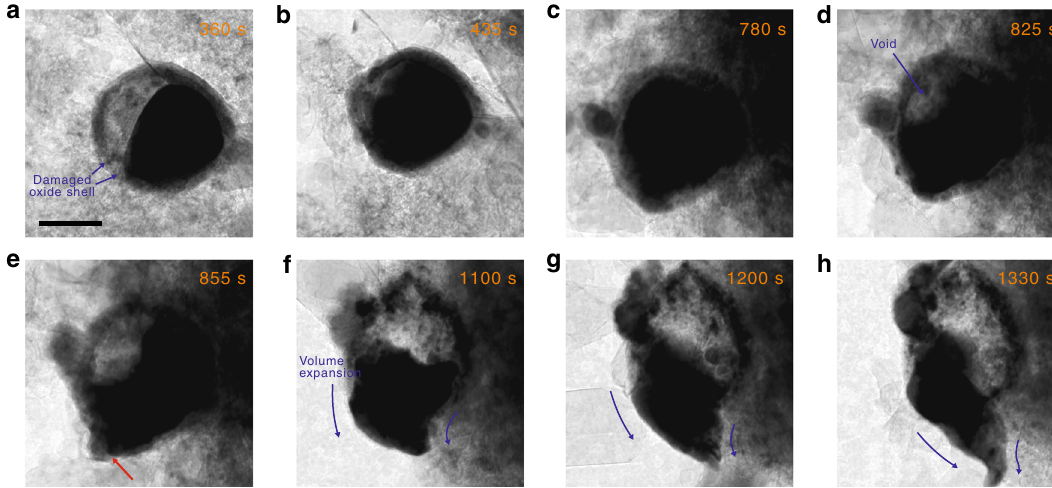
Fig. 3 Time-series images of continued lithiation of a voided particle. a – c The particle repeats lithiation once shell-induced mechanical interaction is released and d self-discharge again upon suf fi cient lithiation. e – h As the shell tears apart, however, the core continues normal lithiation despite being partially attached to the shell. The scale bar indicates 100